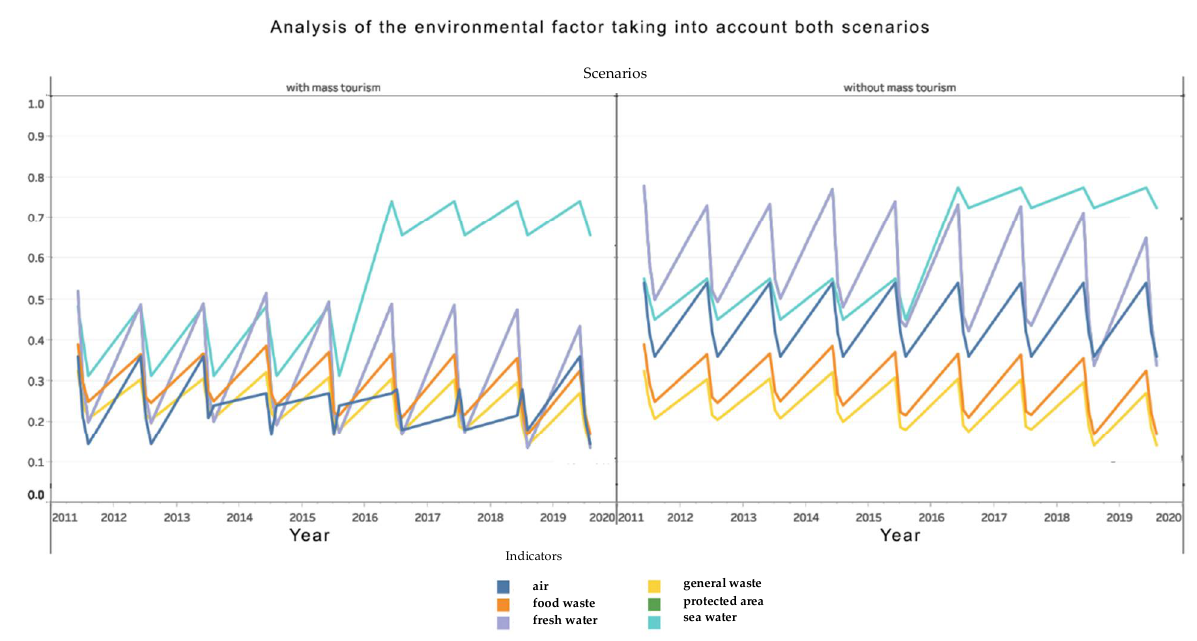
Figure 10. Analysis of environmental factor indicators for the two scenarios.